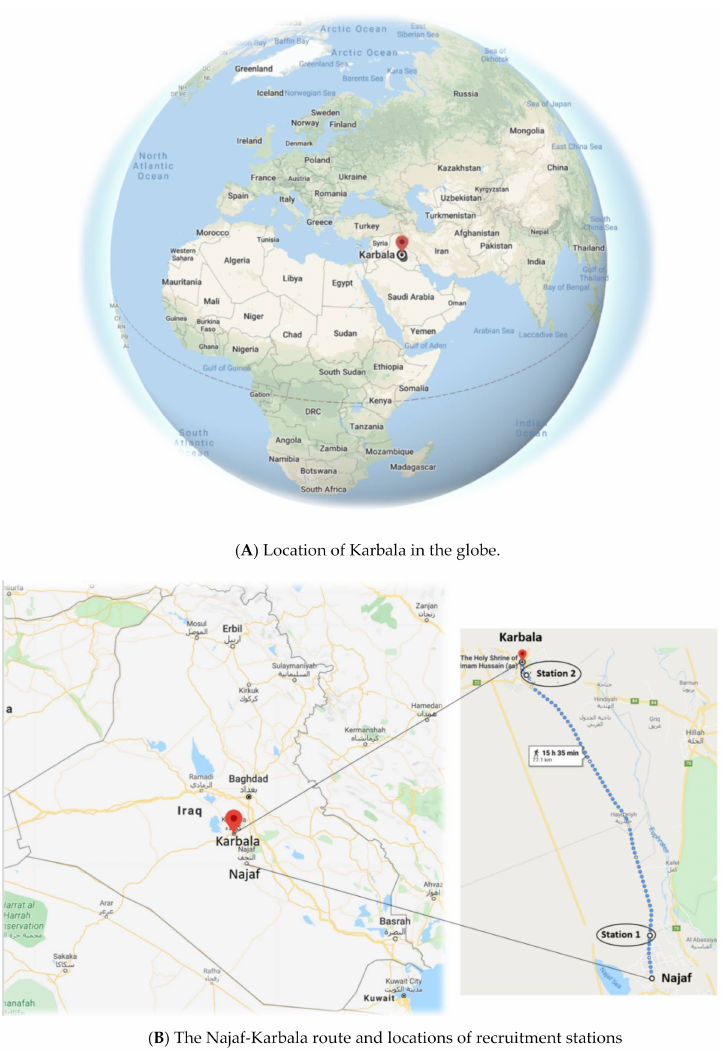
Figure 1. Karbala and its location in the globe ( A ) and in Iraq ( B ). Recruitment stations are shown in Figure 1B. Map adapted from Google Directions (Google Maps, 2020. Karbala, Iraq. Google Maps [online] Available through: https://www.google.com.au/maps/place/Karbala [accessed on 2 June 2020]) and checked by authors familiar with the